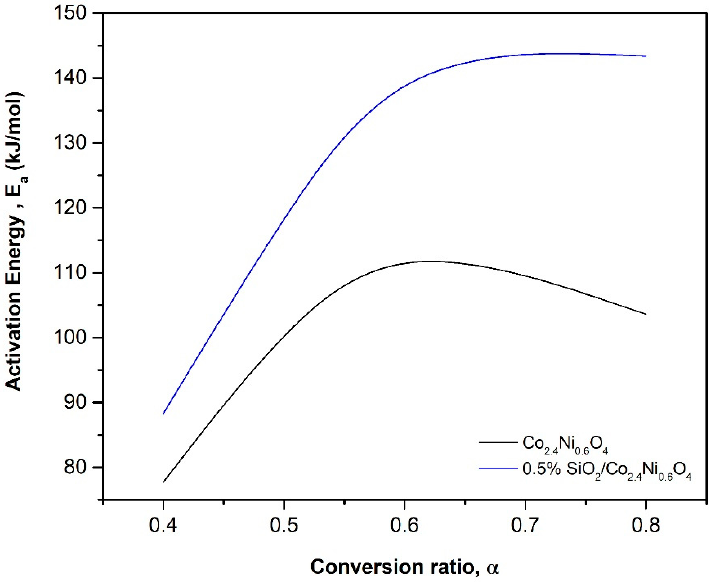
Figure 9. Evolution of the activation energy ( Ea ) with the oxidation ratio ( α ).